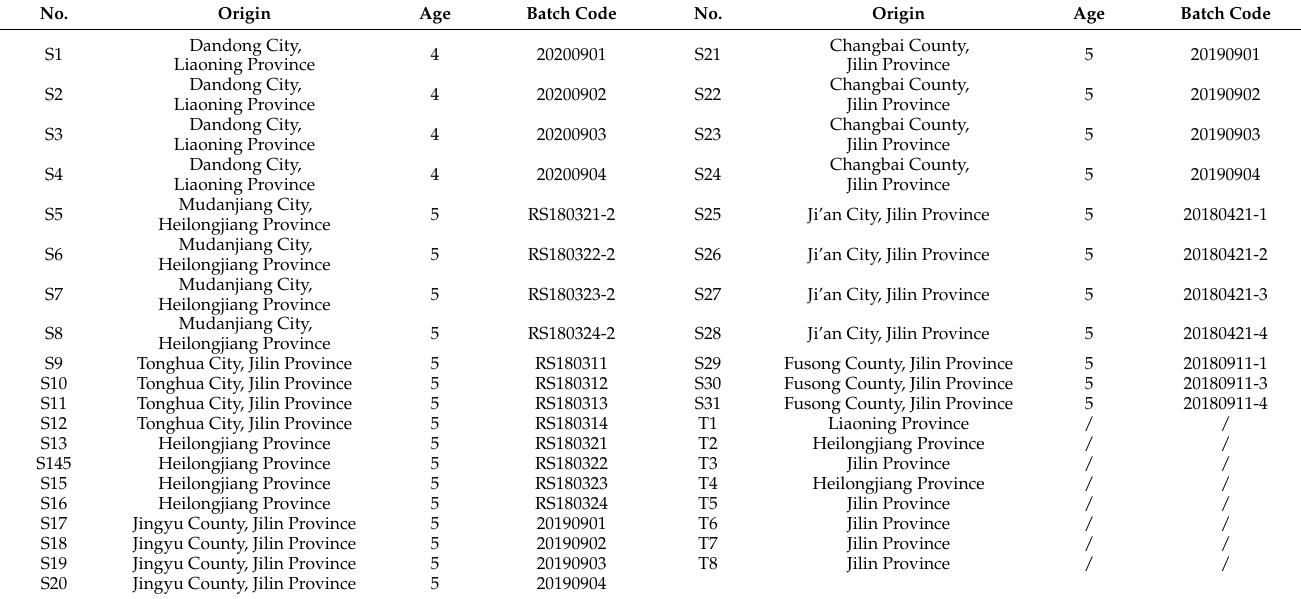
Table 4. Sample information of 39 batches of ginseng